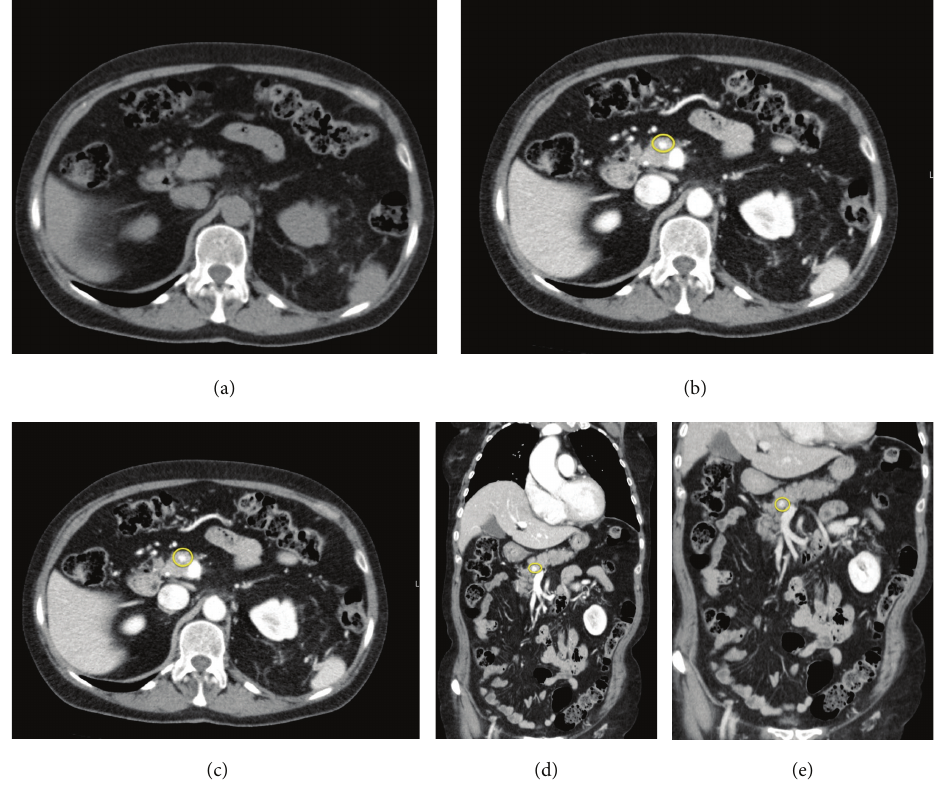
Figure 3: Images show the presence of a round-lesion at the pancreatic istm; the lesion hypodense in the precontrast study (a), appeared hypervascularized in all the three phases of the exam ((b), (c), (d), and (e)). Circles indicate the lesion. (a) Precontrast-Axial. (b) CECT- Arterial Phase-Axial. (c) CECT-Venous Phase-Axial. (d) CECT-Venous Phase. Coronal Plane. (e) CECT-Late Phase-Coronal